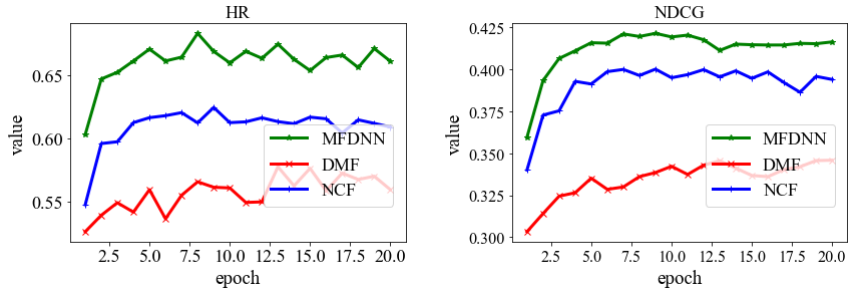
Figure 14. HR and NDCG values for MFDNN and baseline methods.